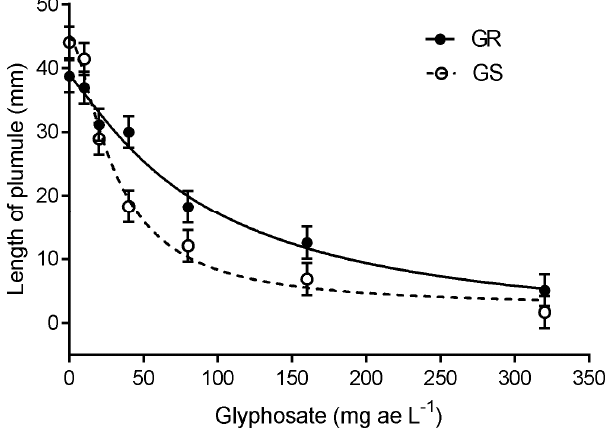
Figure 2. Effects of glyphosate on plumule growth of the progenies of glyphosate-resistant plants (positive control, GR) and glyphosate-susceptible plants (negative control, GS). Symbols indicate mean values, and vertical bars represent ±1 standard error. Non-linear regression models are shown by lines (GR ( p < 0.05 and R 2 = 0.98): y = − 2.0 + (38.8 − ( − 2.0))/(1 + ( x /90.7) 1.2 ) and GS ( p < 0.05 and R 2 = 0.98): y = 2.5 + (45.1 − 2.5)/(1 + ( x /30.5) 1.5 )).